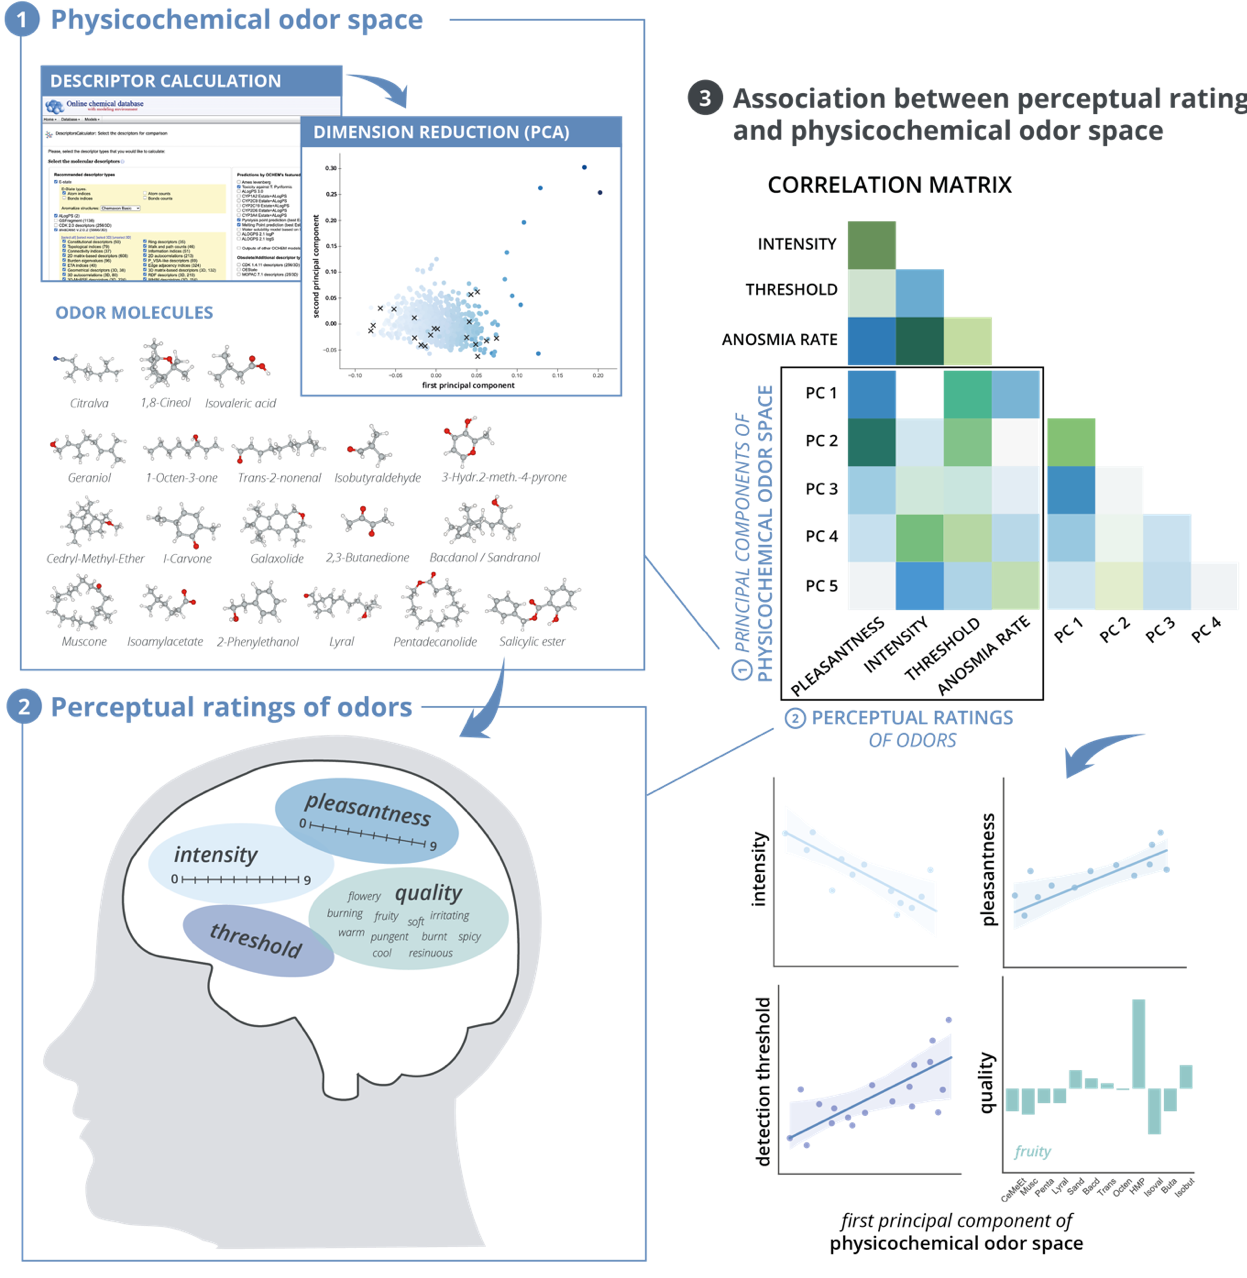
Figure 1. Overview of Methodology and Analyses. ( 1 ) Development of a physicochemical odor space. For 1389 odor molecules, including 20 molecules for which we obtained perceptual ratings (see 3D molecule structure images and ( 2 )), molecular descriptors were calculated using the Online chemical database (https://ochem.eu/, accessed on 12 February 2021). After preprocessing of the dataset, dimension reduction was performed by the means of principal component analysis. The resulting components were used for further analyses (see ( 3 )). ( 2 ) Perceptual ratings of odors. For 20 of the 1389 odor molecules, perceptual ratings were obtained from a dataset with n = 2000 subjects that were tested with one or more odors in groups of n ~200 (Croy et al. [6]. The detection threshold and ratings of intensity, pleasantness and qualitative dimension were investigated for differences between the odors. ( 3 ) Association between perception and odor space. Finally, the values of the first principal components of the odor space for each odor were correlated with their corresponding perceptual dimensions of pleasantness, intensity and detection threshold. For the qualitative ratings, individual plots were generated showing the frequency of naming a specific qualitative descriptor for each odor molecule. Note: Plots show schematic visualizations. Three-dimensional molecules were drawn using VESTA software